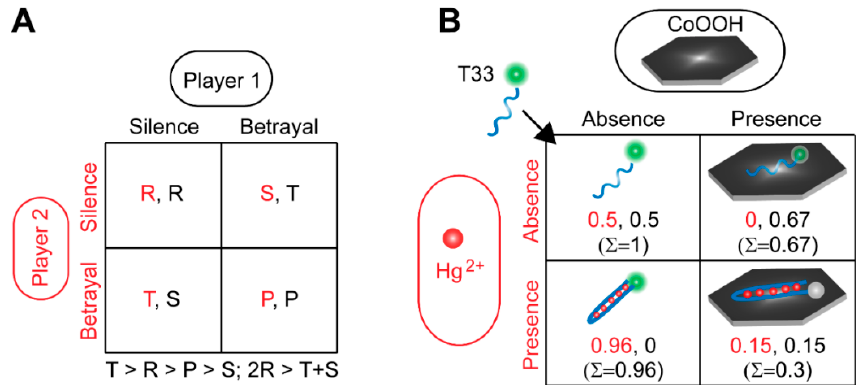
Figure 4. ( A ) Generalized payoff matrix for prisoner’s dilemma where the two players are represented by red and black, and each player chooses to either silence or betrayal; ( B ) Realized payoff matrix for the molecular interaction of the bait molecule T33 with two molecular players, CoOOH and Hg 2+ , with different states (absence = silence and presence = betrayal) regarded as strategies, resulting in conflicts (sharing or self-interest) of fluorescence distribution change of T33, which conforms to the prisoner’s dilemma.